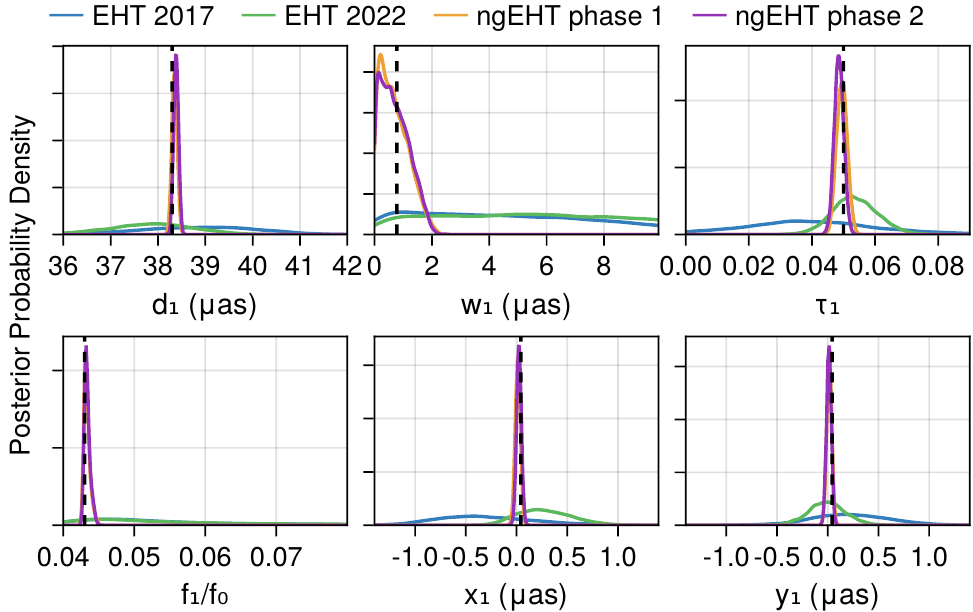
Figure 3. Geometric self-fit marginal posterior distributions for the examples shown in Figure 2. The curves show the marginal posterior distributions for n = 1 ring parameters of interest: diameter ( d 1 ), width ( w 1 ), ellipticity ( τ 1 ), fractional flux density ( f 1 / f 0 ) , and relative displacement ( x 1 , y 1 ). The black dashed line shows the true value for the n = 1 ring component. Overall, we find that the EHT 2017 and 2022 coverage is insufficient to fully constrain the second ring. In particular, the width of the n = 1 ring component is the most difficult quantity to